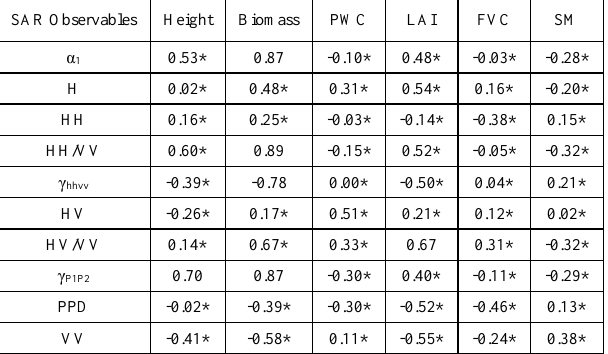
Table 4. Correlation (R Pearson) between SAR observables and field estimations for K10 (wheat). Non-significant correlations at 95% confidence level are indicated by *.